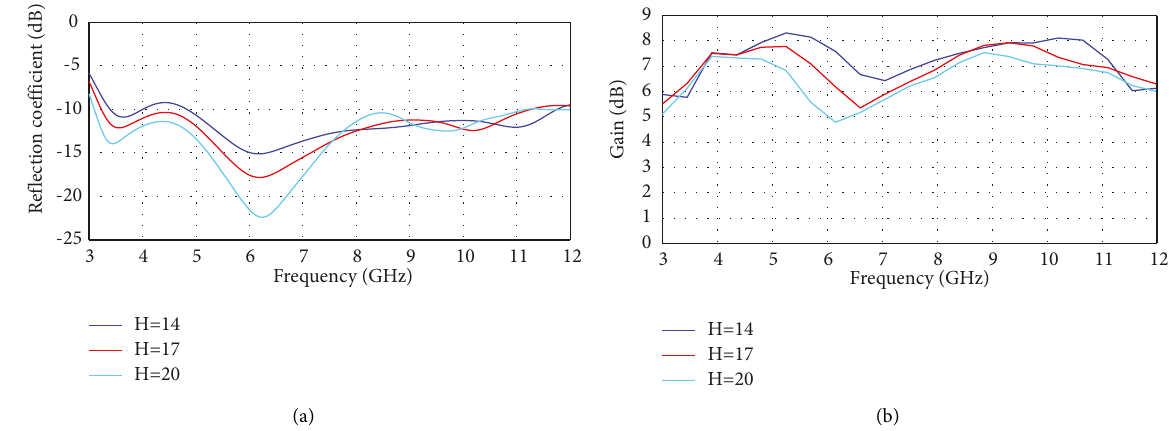
Figure 7: Simulated (a) reflection coefficient and (b) gain with different gap values between FSS and